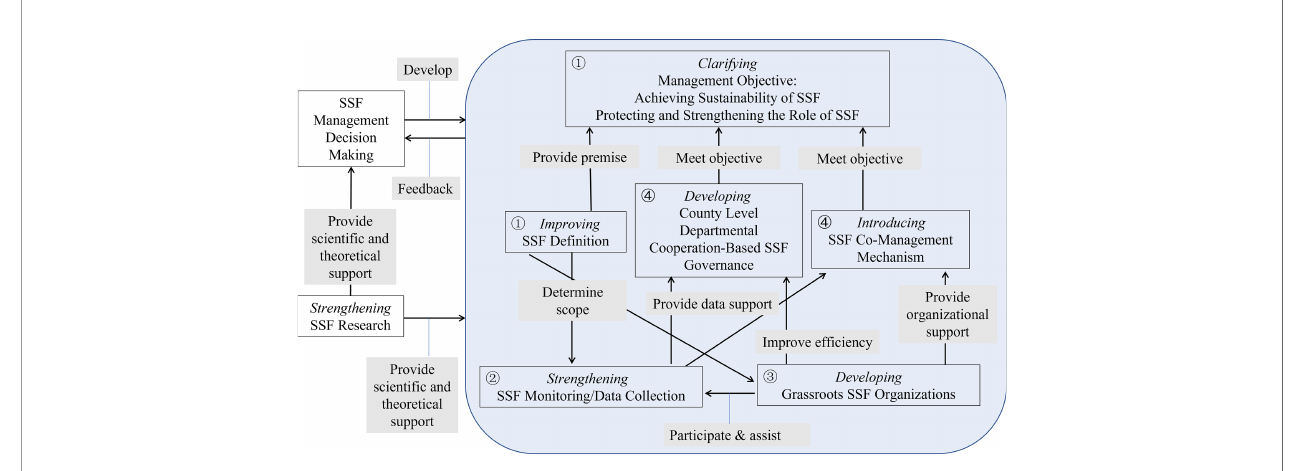
FIGURE 6 | A proposed strategy to improve SSF management in